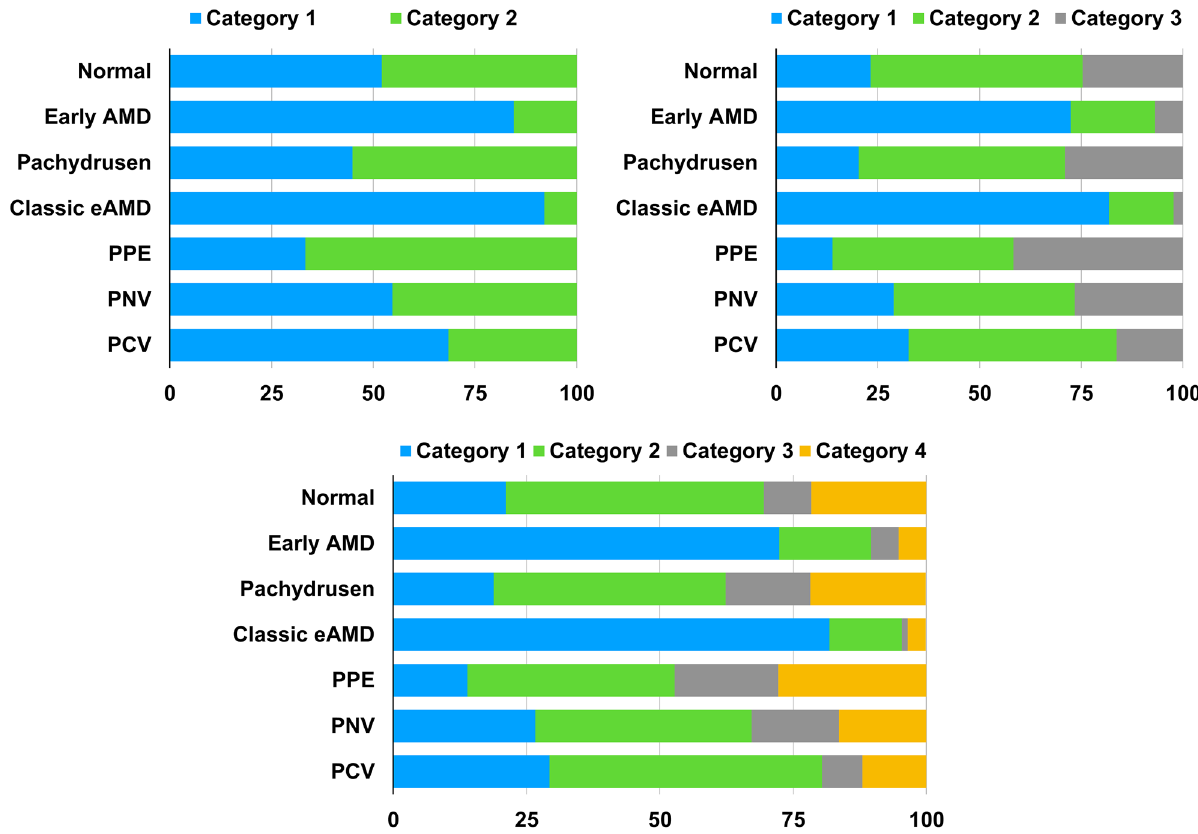
Figure 1. Clustering of eyes with age-related macular degeneration or pachychoroid spectrum diseases among categories based on the choroidal thickness profiles. Early AMD, early AMD with soft drusen or reticular pseudodrusen; eAMD , exudative age-related macular degeneration; PPE, pachychoroid pigment epitheliopathy; PNV, pachychoroid neovasculopathy; PCV, polypoidal choroidal